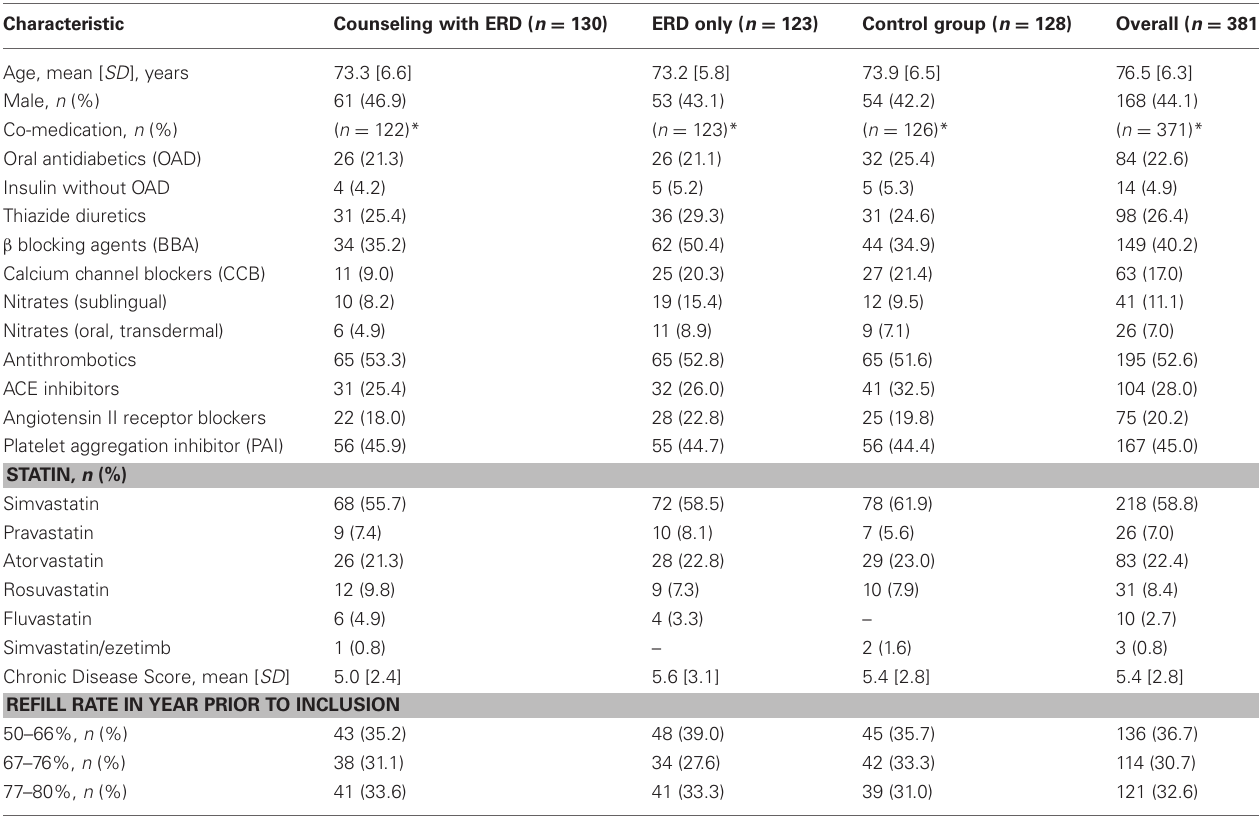
Table 1 | Baseline characteristics of study